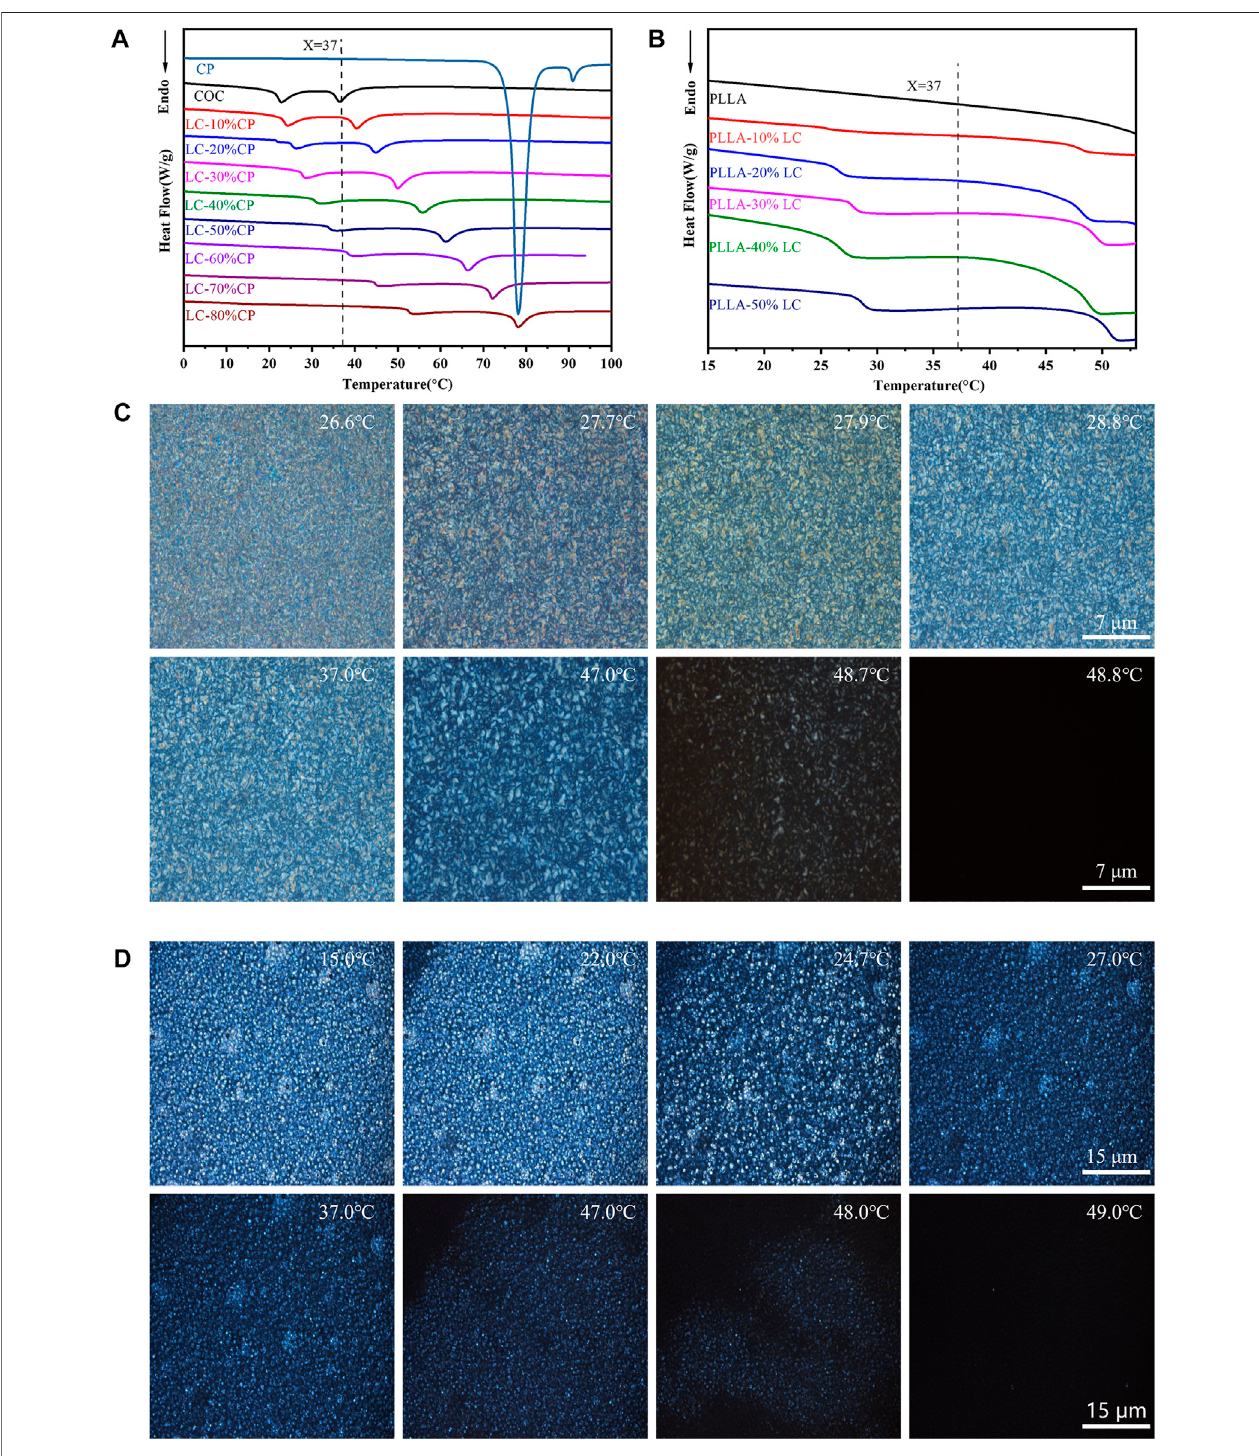
FIGURE 1 | Thermal properties of the composite LC. (A) DSC curve of COC/CP LC; (B) DSC curve of PLLA/LC composite fi lms; (C) blended LC LC-30% CP LC texture observed under POM; and (D) LC texture of the PLLA-30% LC composite fi lms observed under POM.